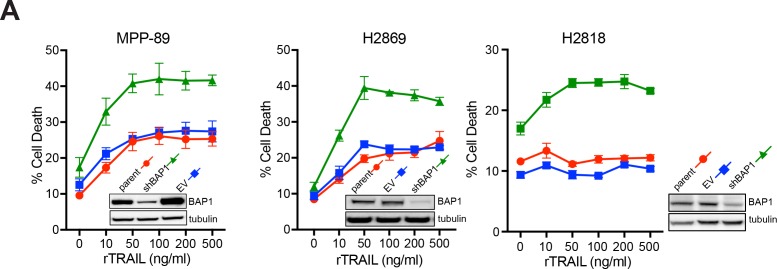
shRNA knockdown of BAP1 increases sensitivity to rTRAIL in MM cells. Three BAP1-wild-type MM cell lines (A) MPP-89, (B) H2869 and (C) H2818 were transduced with empty vector (EV) or BAP1 shRNA (shBAP1). Immunoblot confirmed BAP1 knockdown. The parental, EV and shBAP1 cells were treated with rTRAIL for 24 hr and cell death measured by Annexin V/DAPI flow cytometry assay.